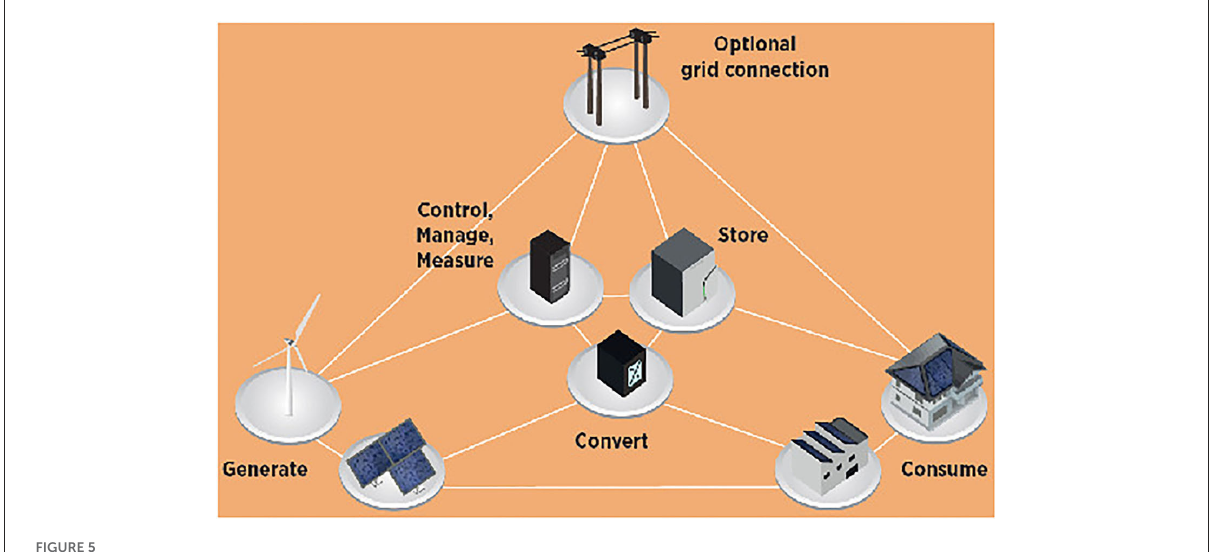
FIGURE5 A design of renewable mini grid (Irena,